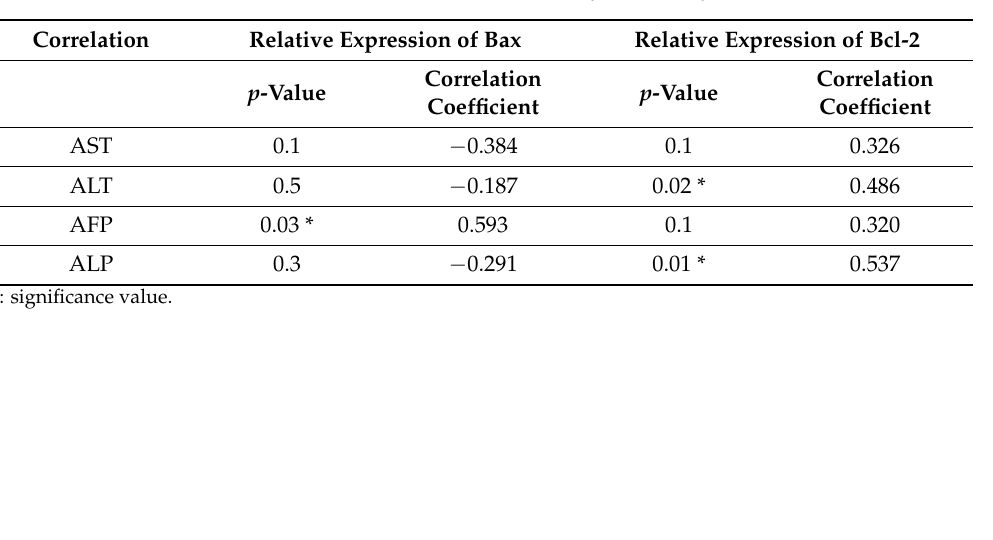
Table 5. Correlation between Bax, Bcl-2, and serum liver enzyme